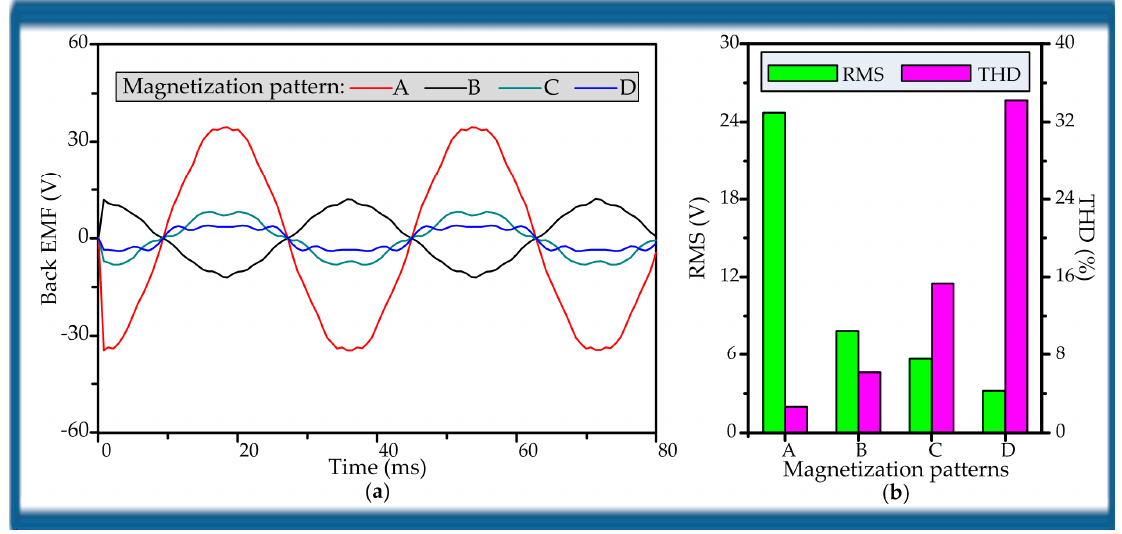
Figure 6. Single-phase back EMFs with different magnetization patterns: ( a ) Back EMF waveforms; ( b ) Corresponding RMS and THD.